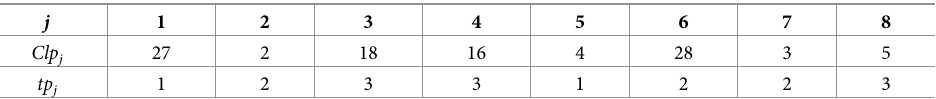
Table 4. Estimated transmission time for each packet pt j and confidentiality level distribution for LTF